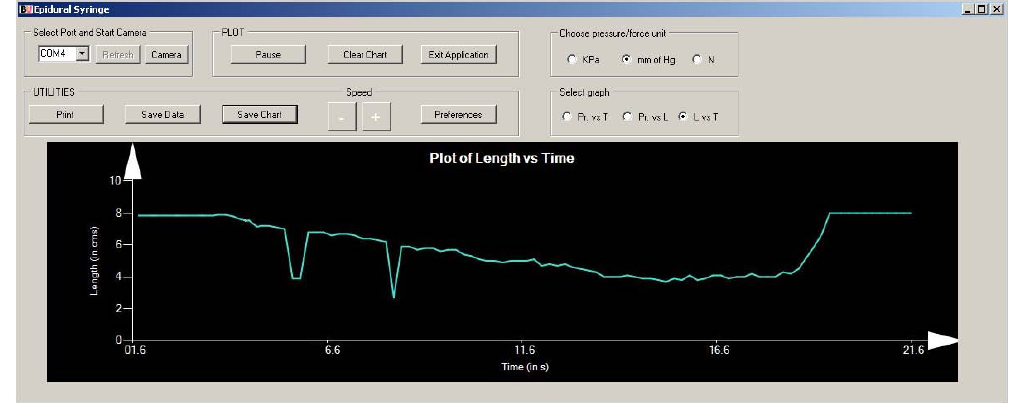
Figure 5. Software output measuring needle length. Table 1. Force ( N ) estimates for each tissue during needle insertions into porcine cadaver. Insertion Skin Subcutaneous Supraspinous Interspinous Ligamentum Epidural Dura number fat ligament ligament flavum space